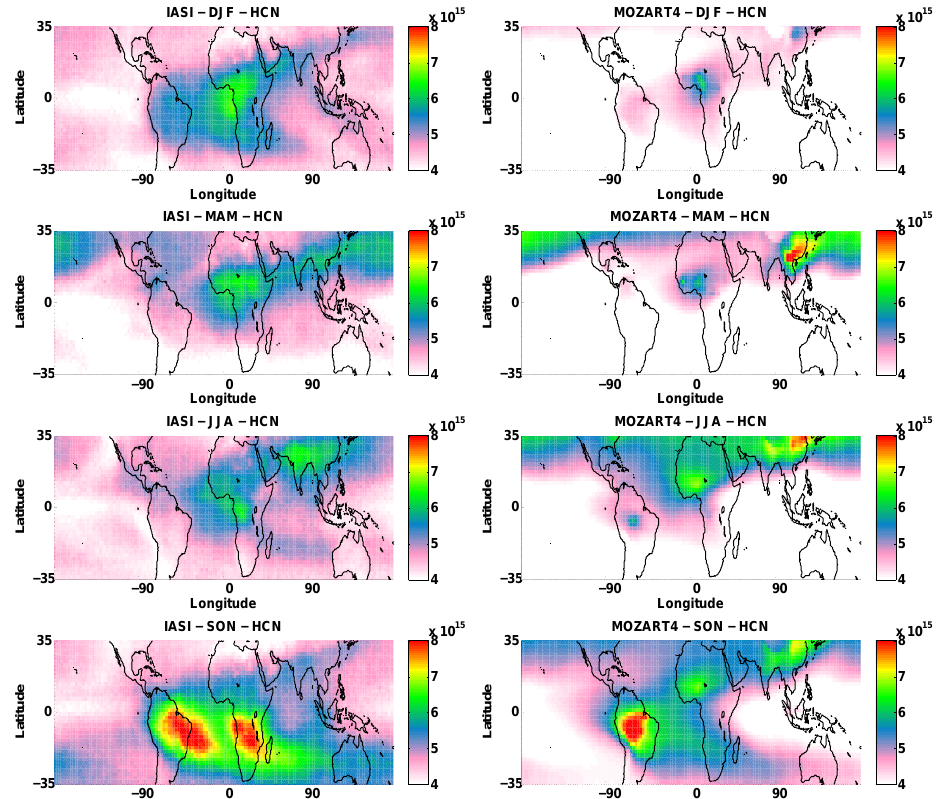
Figure 8. Same as Figure 9 for HCN. Figure 10. Same as Fig. 9 for